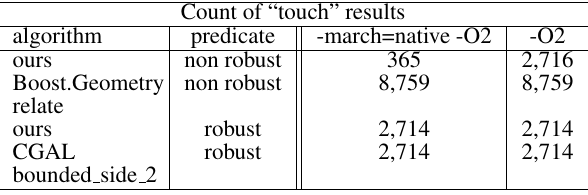
Table 5. Count of “touch” results between continental Russia polygon (Kelso and Patterson, 2010) and query points resulted from a linear interpolation of the polygon; ours: our winding count